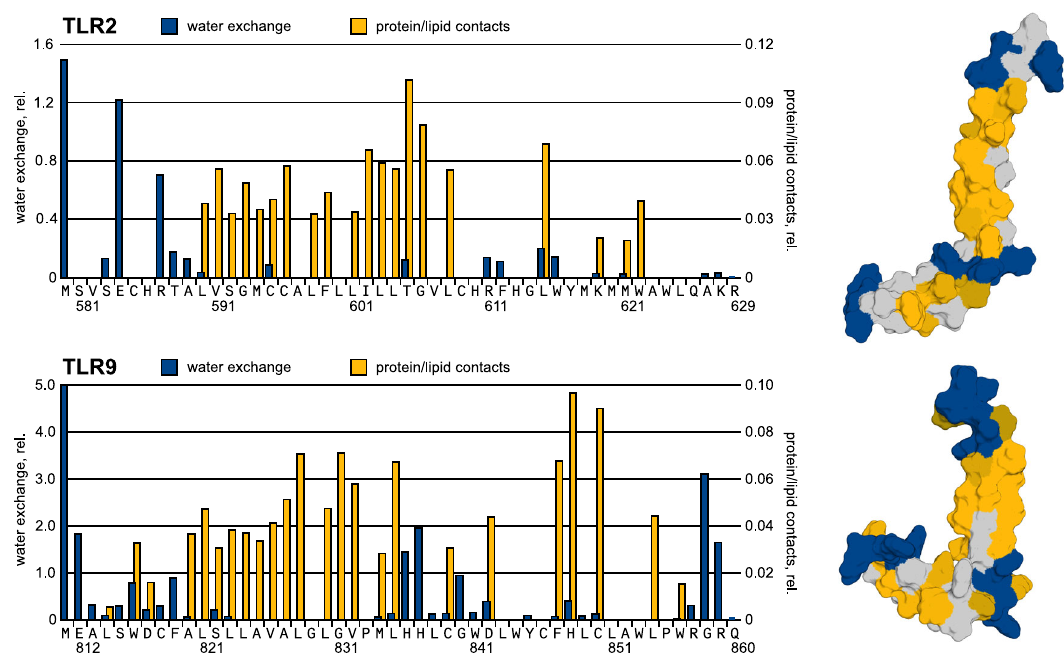
Fig. 4 | Interaction of TLR2tmjm and TLR9tmjm with lipid and aqueous environment. Bar plots indicate the intensities of NOE peaks between the amide protons and CH 2 protons of lipids (yellow) and NOE exchange peaks between the amide protons and water (blue). Each value was normalized to the intensities of